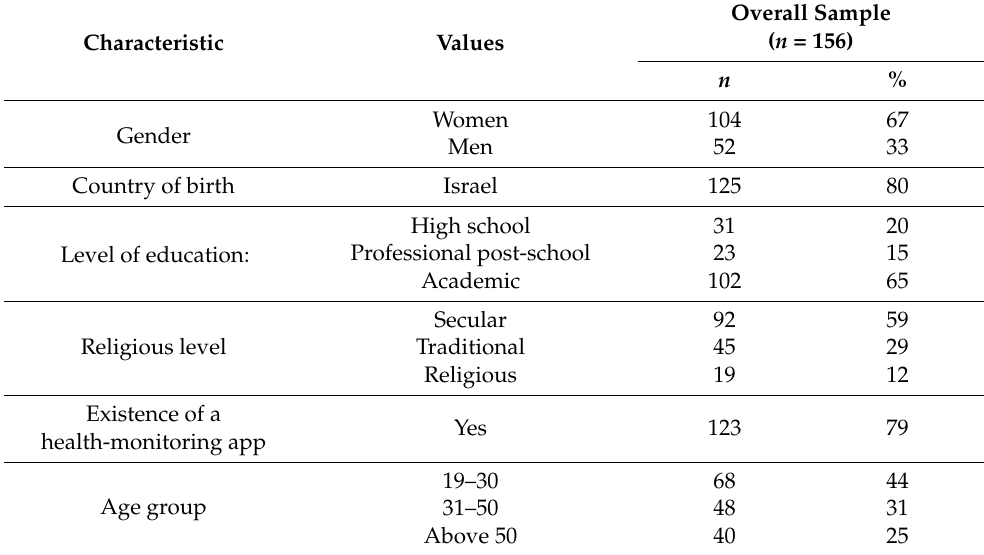
Table 1. Description of the sample